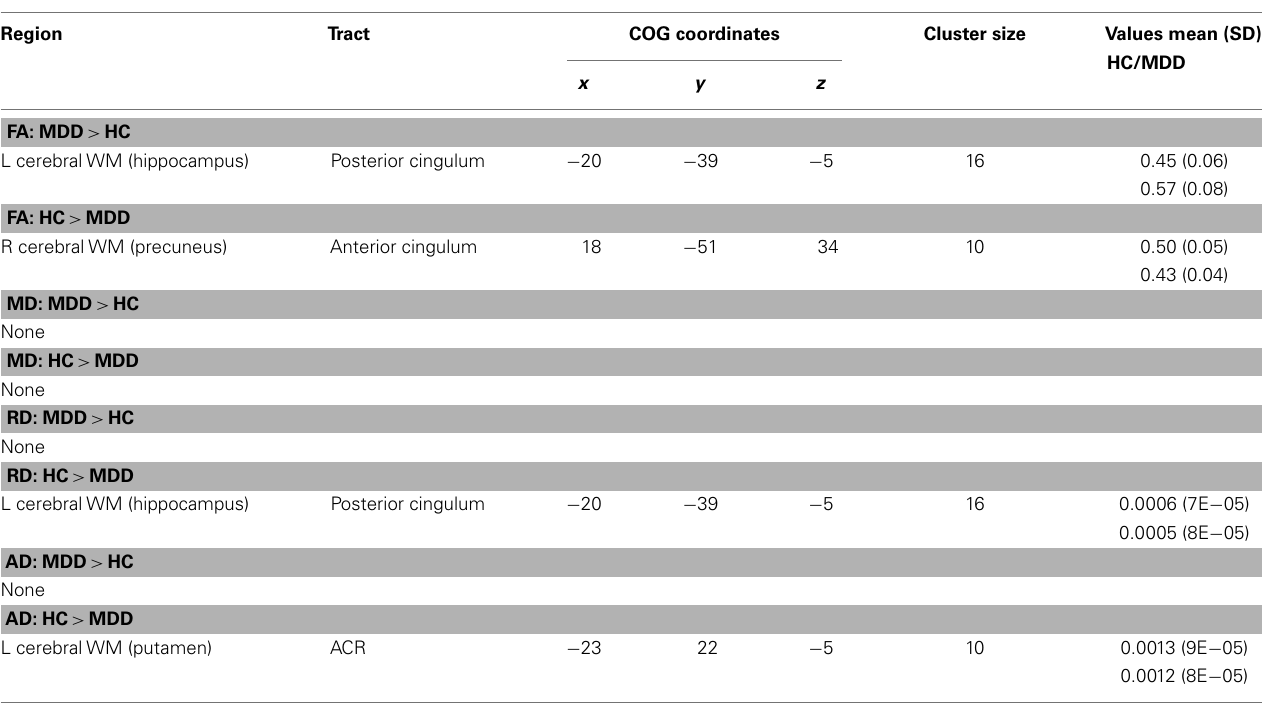
Table 2 |Voxel-wise group comparison results.